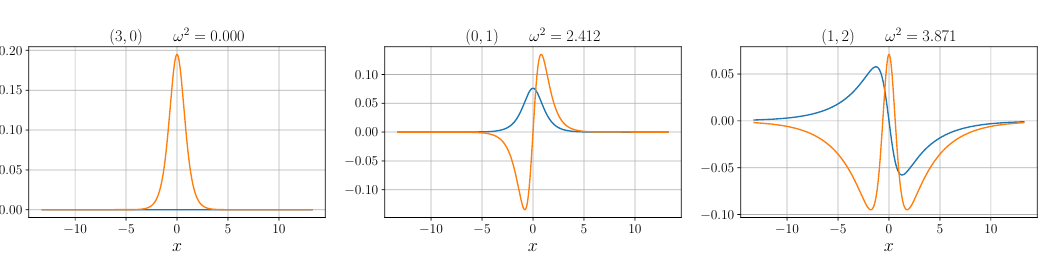
= − tanh x, ψ c = 1 . 0 0